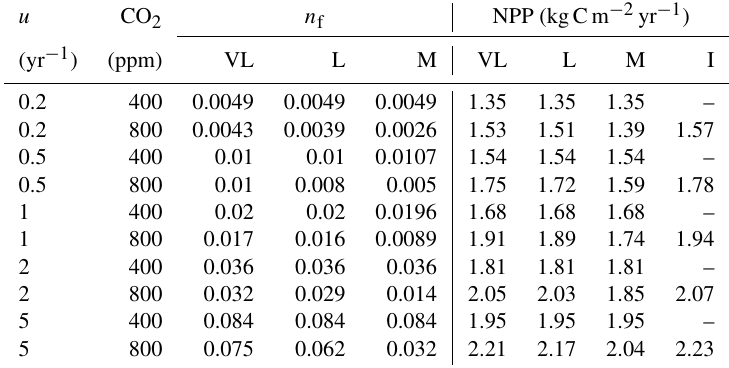
Table 4. Relationship between nitrogen uptake coefficient ( u ) and quasi-equilibrium points of leaf N:C ratio ( n f ) and net primary production (NPP) in the very long (VL), long (L), medium (M) and instantaneous time